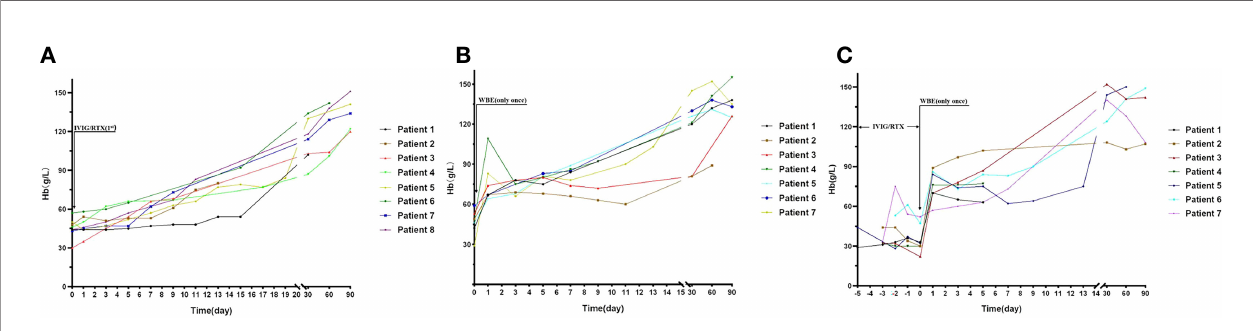
FIGURE 1 | The alteration of Hb levels with time after second-line therapy (IVIG/RTX) and WBE in groups 1, 2, and 3. (A) Hb levels at different time points in patients of group 1. (B) Hb levels at different time points in patients of group 2. (C) Hb levels at different time points in patients of group 3. Group 1 (IVIG/RTX, n = 8); group 2